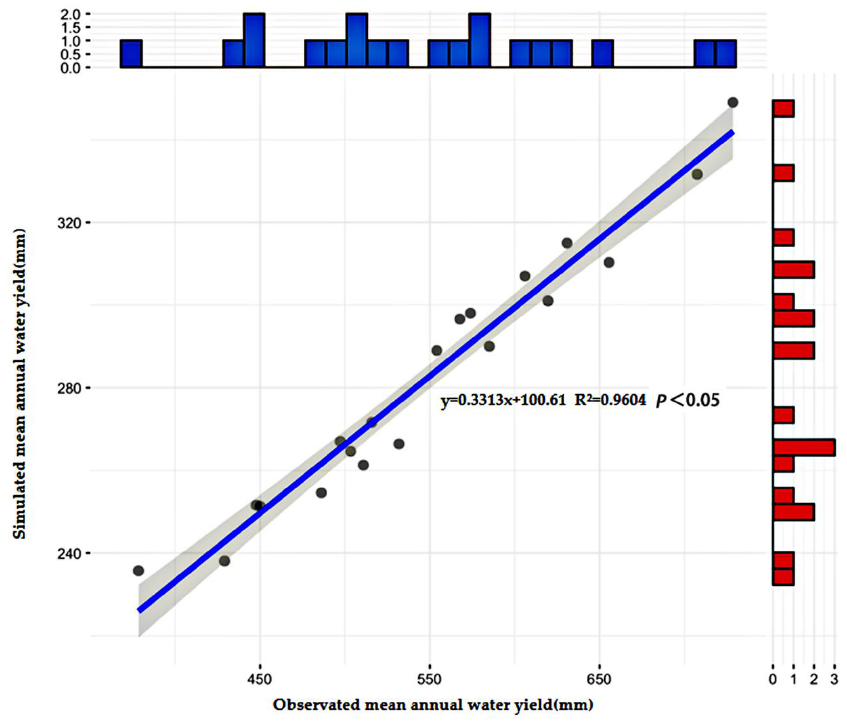
Figure 8. InVEST modeled mean annual water yield against observed mean annual water yield. Blue line indicates a relationship with intercept = zero and slope = one.